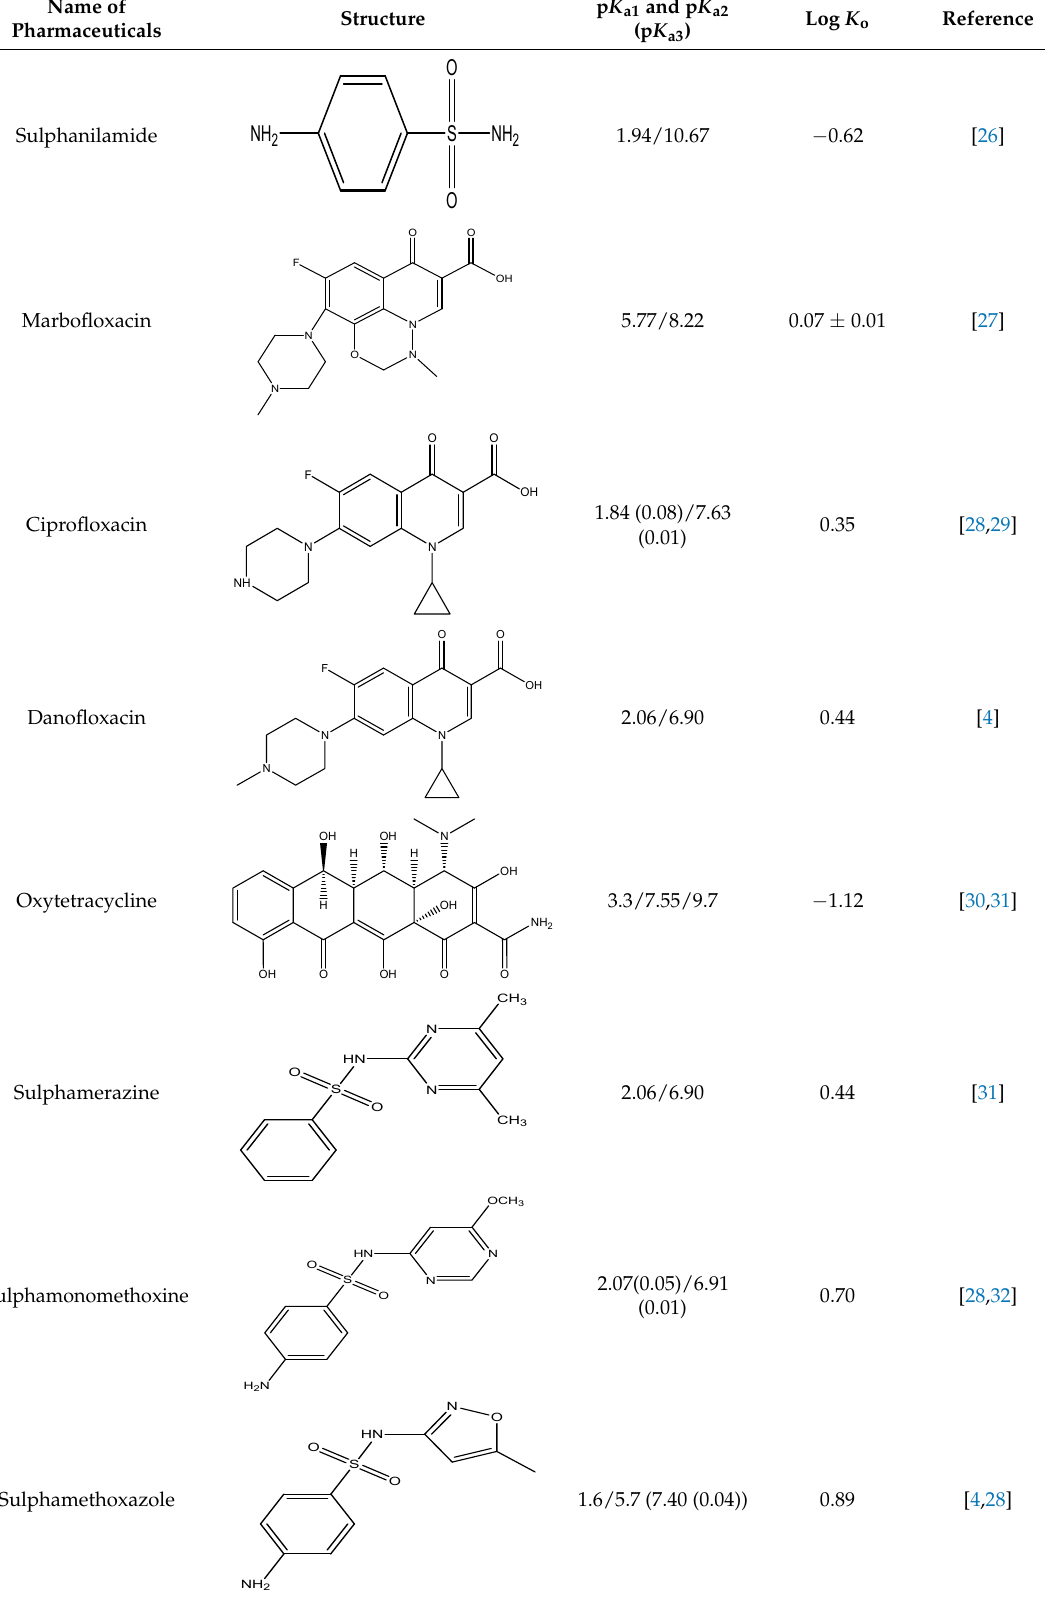
Table 1. Molecular structure and physicochemical properties of selected analytes.